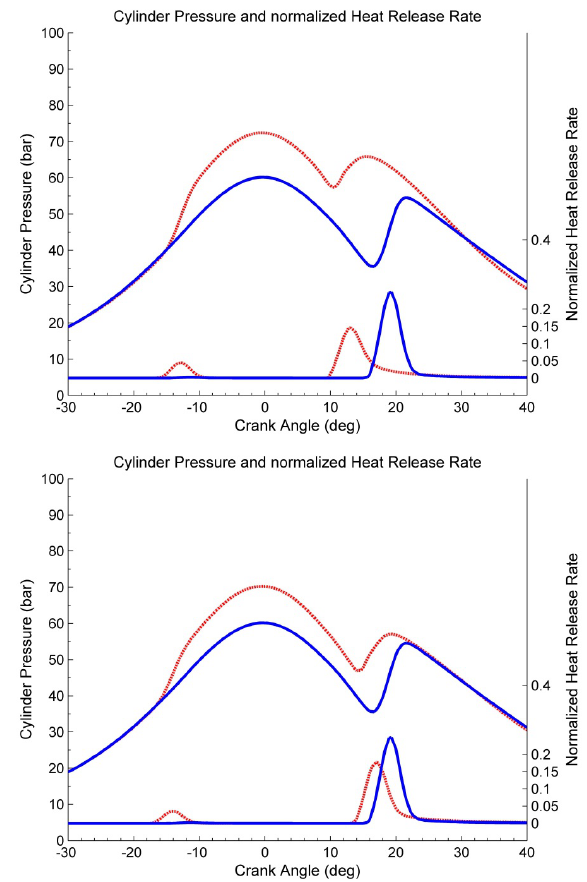
Fig. 7: Comparisons of cylinder pressure and HRR data for first itera- tion and optimum cases.